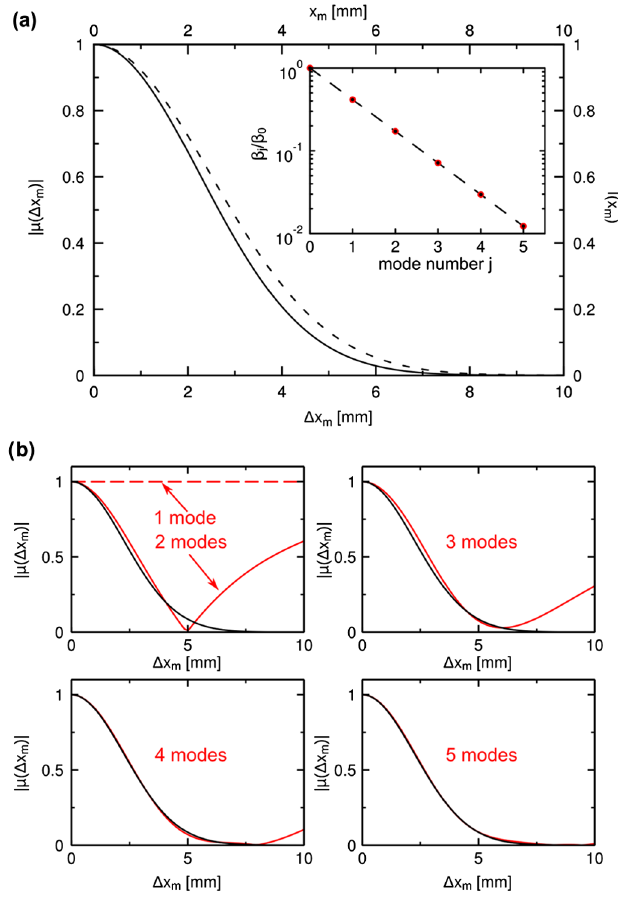
FIG. 9. (a) The modulus of the complex coherence factor j (cid:4) ð (cid:1) x Þj at the entrance of the autocorrelator for FLASH pulses at (cid:1) ¼ 24 nm (solid line, lower abscissa). The dashed line represents the intensity distribution I ð x Þ (upper abscissa). The =(cid:10) 0 of the eigenvalue (cid:10) to the lowest inset shows the ratio (cid:10) j j order eigenvalue (cid:10) 0 as a function of the mode number j . (b) The contribution of the transverse modes to the complex coherence Þj . factor j (cid:4) ð (cid:1) x m